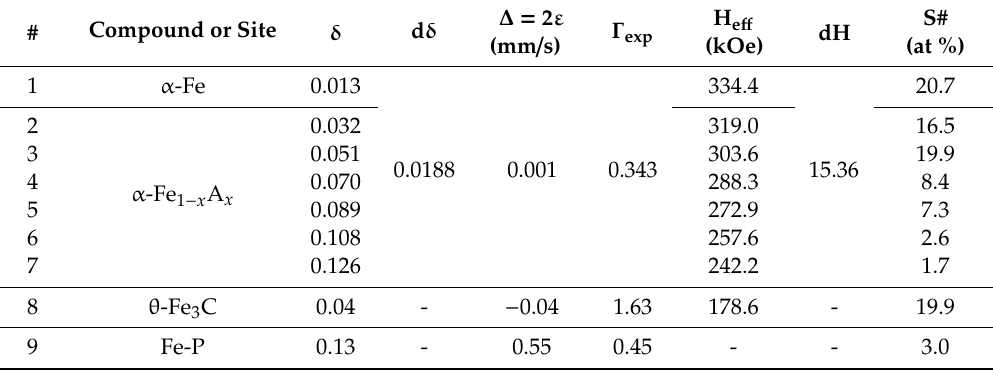
Figure 12. Mössbauer spectra of pig iron sample obtained at 296 K. Table 6. Mössbauer spectra parameters of pig iron obtained at 296